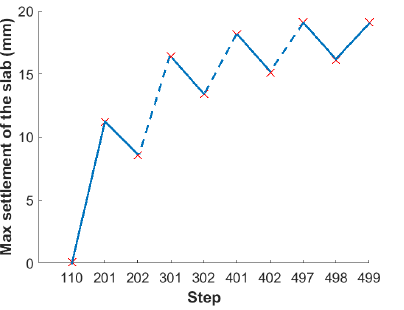
Fig. 5. Evolution of maximum settlement of slab vs steps. The meaning of each step is explained in